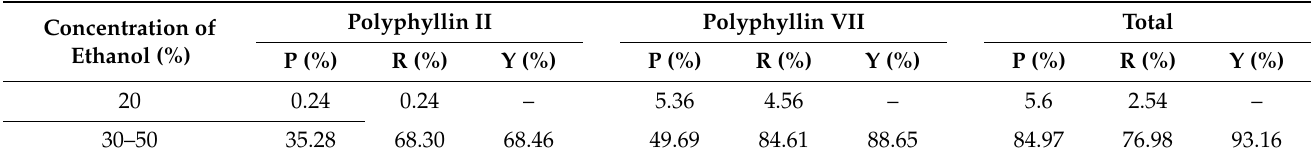
Table 9. Results of the optimization elution method for the two saponins.